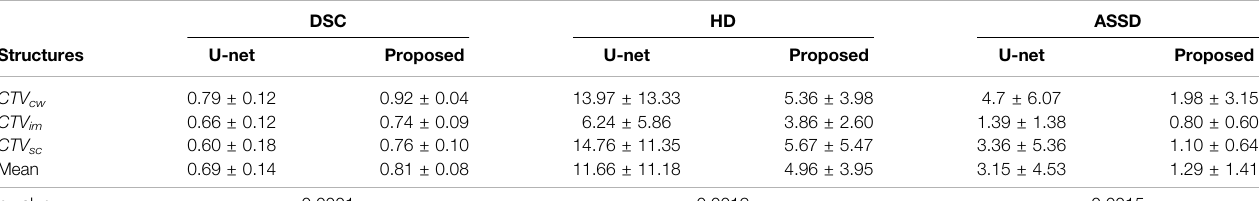
TABLE 1 | Quantitative evaluation of the proposed method and U-Net on CTV cw , CTV im , and CTV sc in terms of DSC, HD and ASSD. The p value smaller than 0.05 indicates that there are signi fi cant differences between the two approaches. DSC